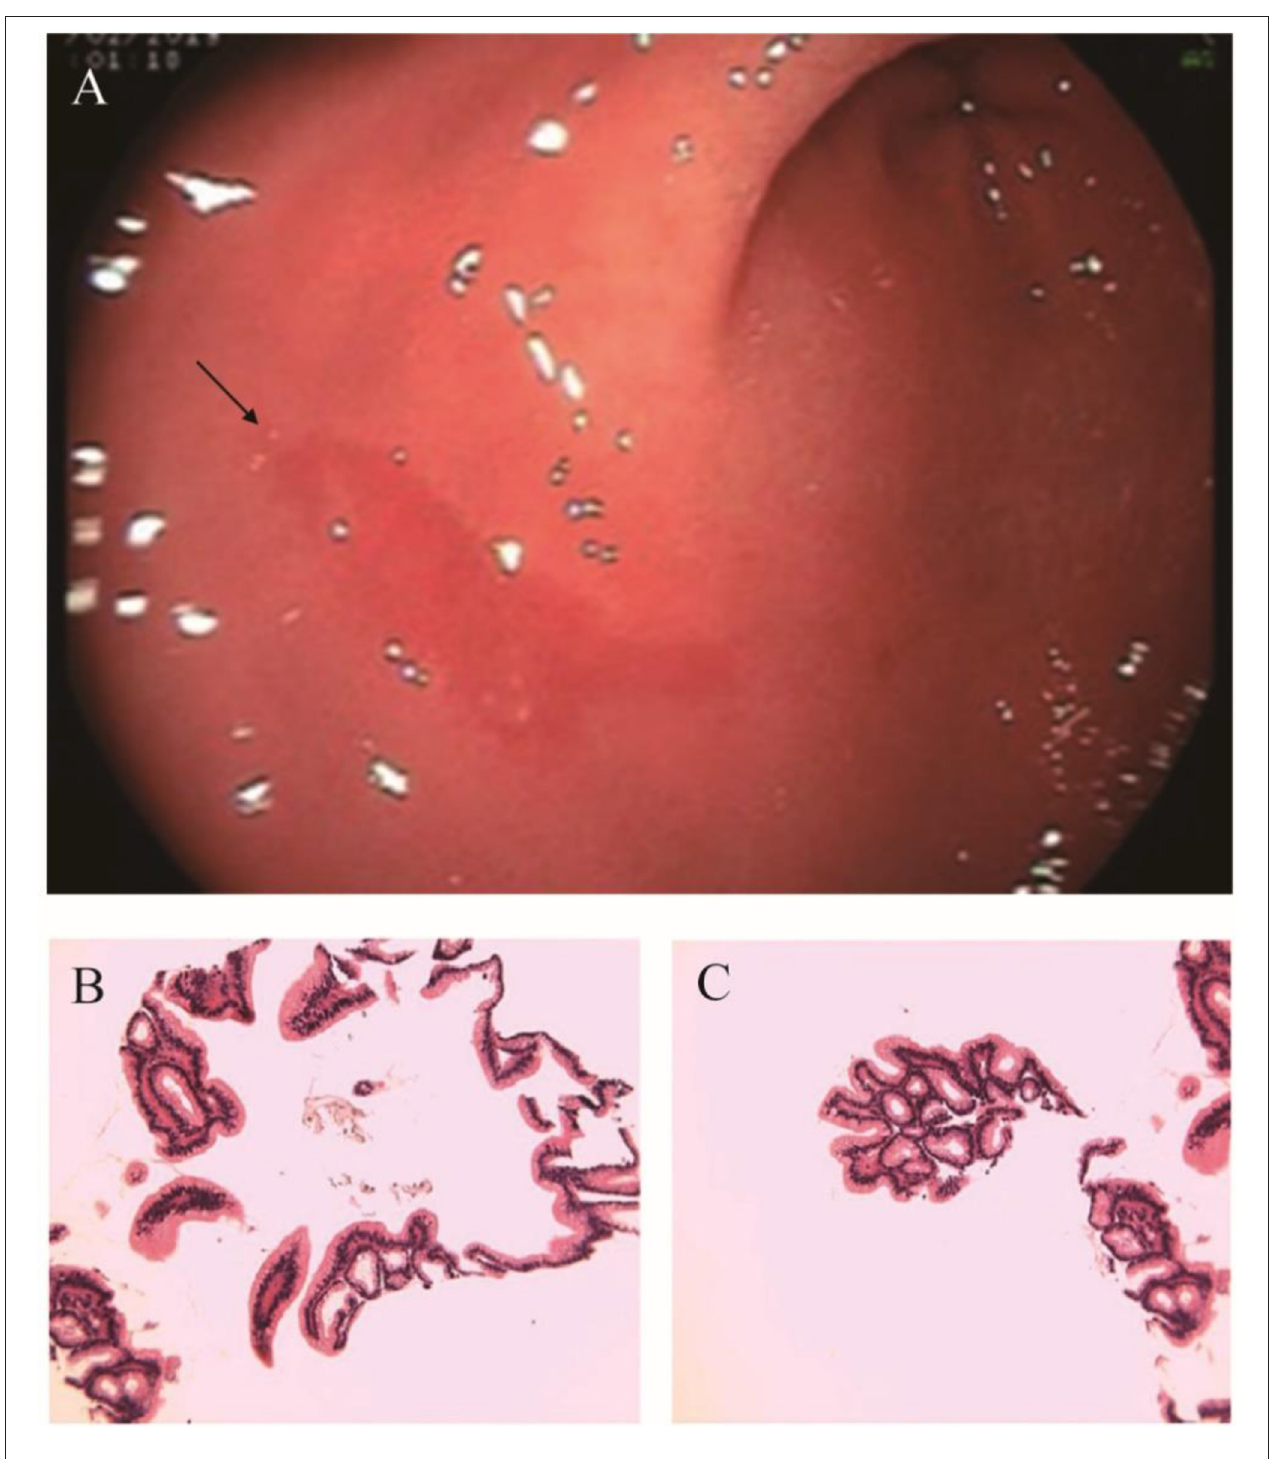
FIGURE 3 | (A) Electronic gastroscopy. (B,C) Gastric antrum pathology.